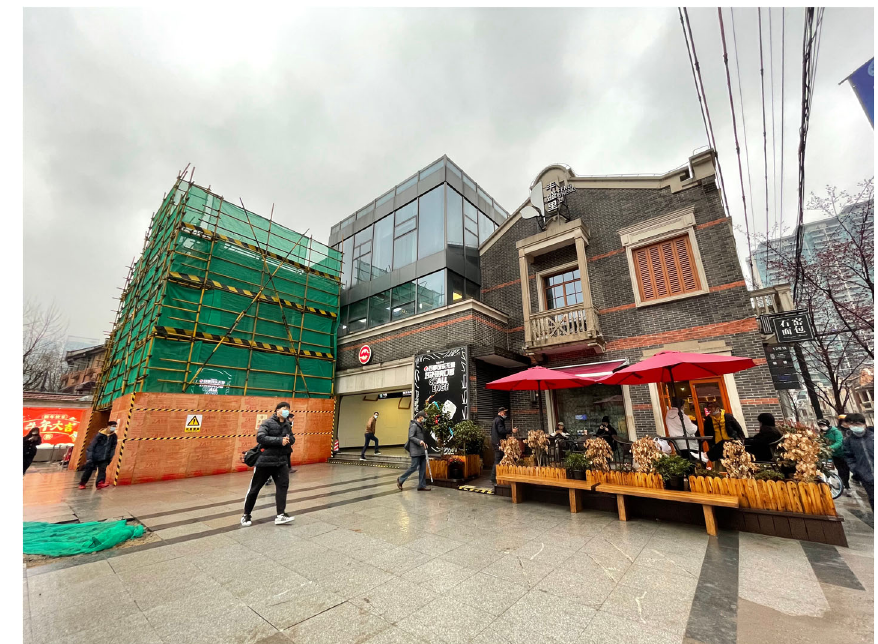
Fig. 3 Entrance to West Nanjing Road Metro Station (metro line 12). (Source: the